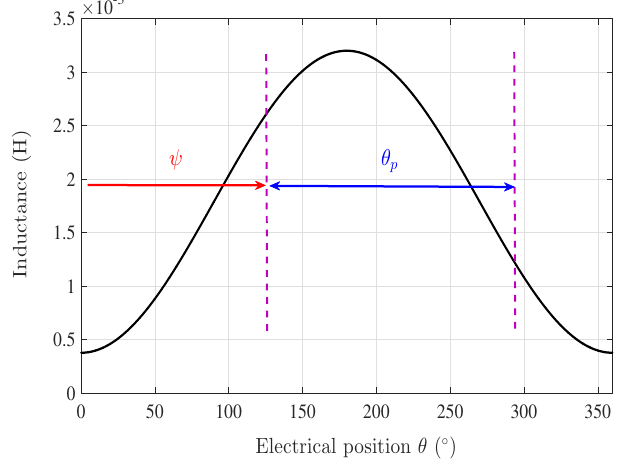
Figure 1. Phase inductance variation versus